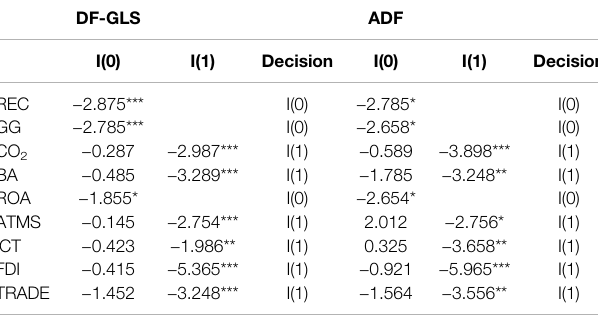
TABLE 2 | Unit root